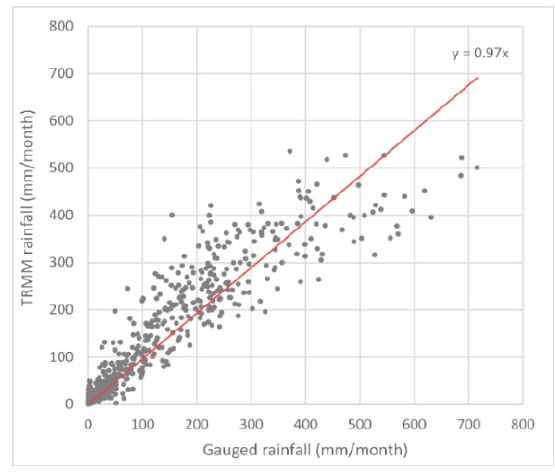
Figure A2. Comparison of TRMM data with measured monthly rainfall averaged per pixel for gauges in pixels with multiple stations. The red line gives the linear regression best fit with 0 intercept.